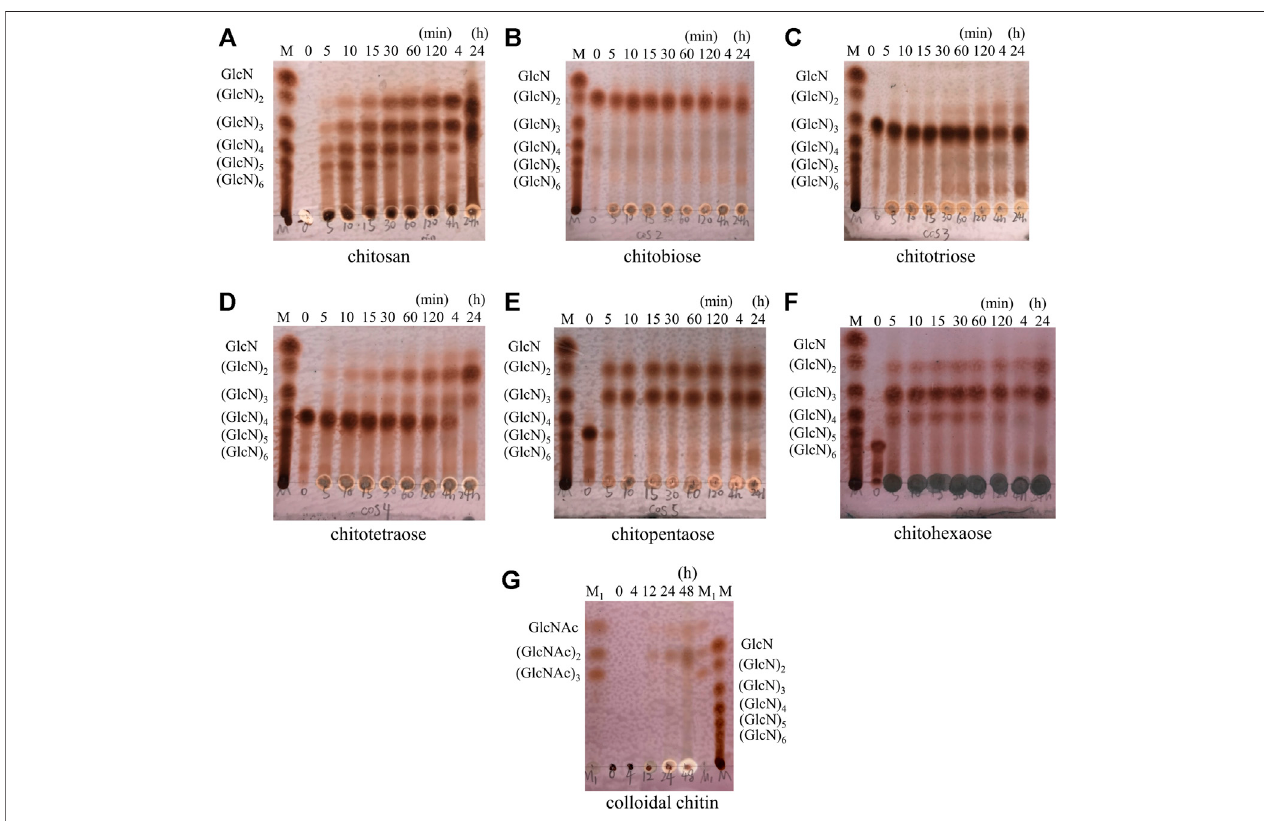
FIGURE 4 | Hydrolytic process of AoNagase toward chitosan, COS (DP 2 – 6) and colloidal chitin by TLC. The substrates were chitosan (A) (GlcN) 2 (B) (GlcN) 3 (C) (GlcN) 4 (D) (GlcN) 5 (E) (GlcN) 6 (F) and colloidal chitin (G) . Lane M (GlcN) 1 – 6 ; Lane M 1 (GlcNAc) 1 – 3